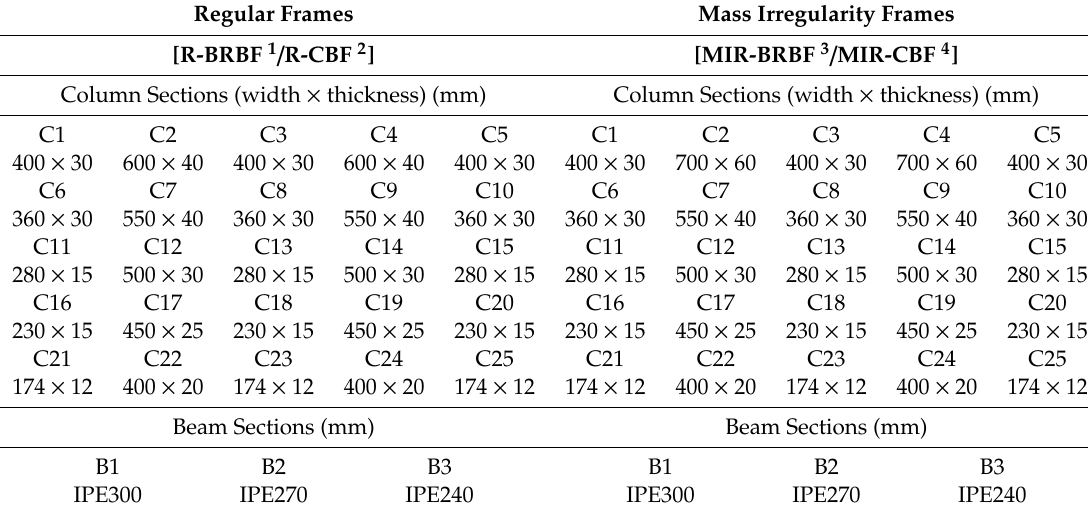
Table 2. Columns and beams cross sections—15-Story